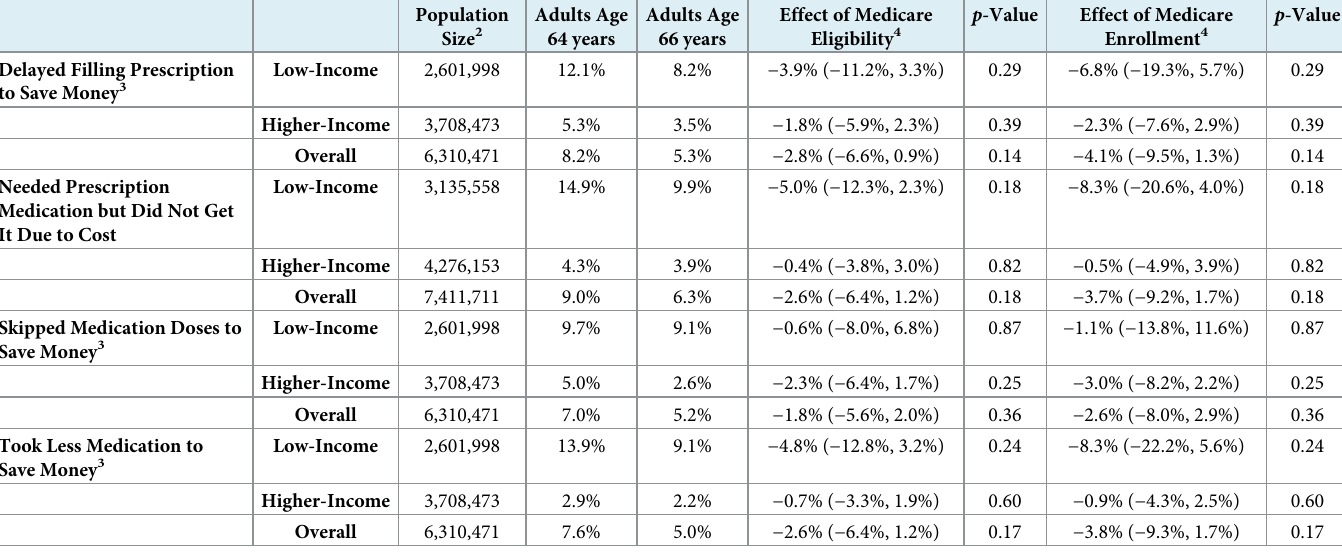
Table 3. Association of Medicare eligibility and enrollment with prescription medications by income level 1 .